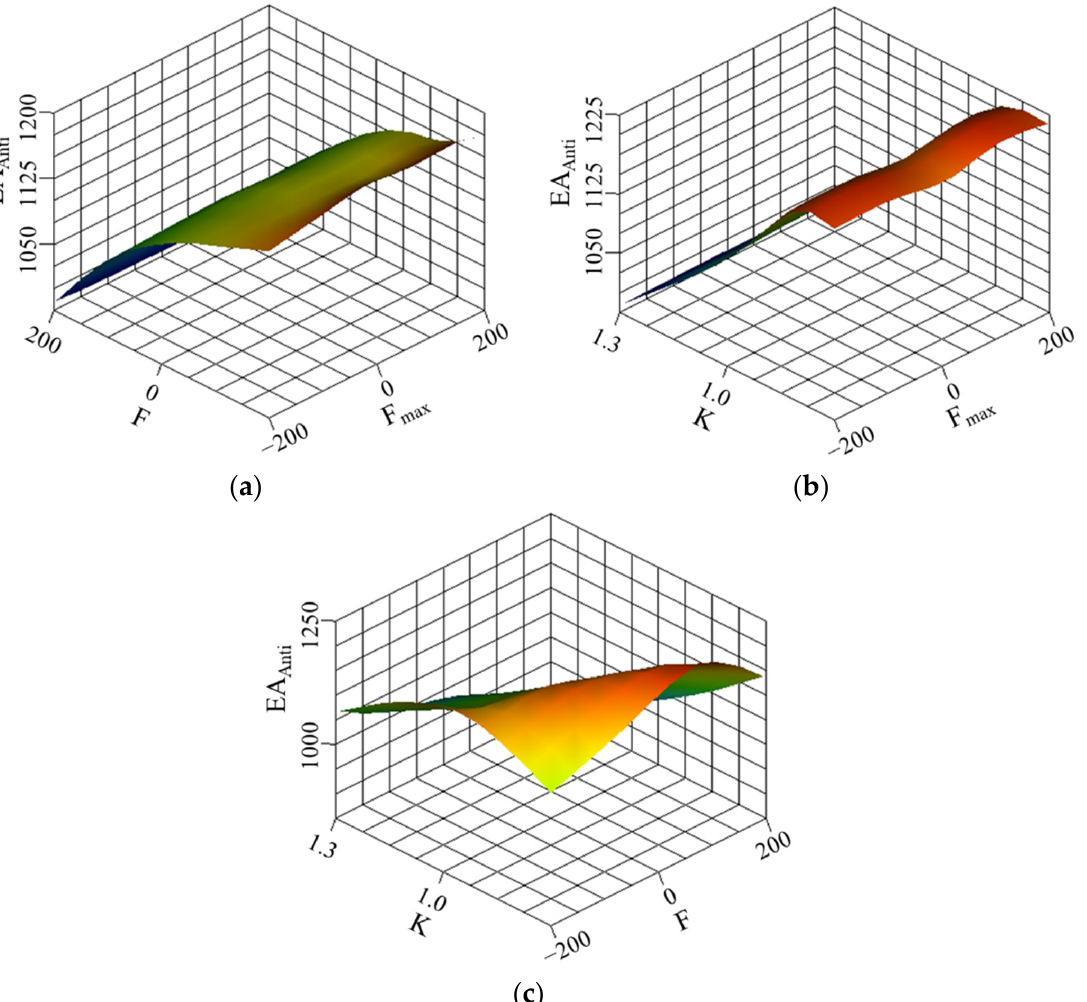
Figure 20. Influence of three variables on EA Anti : ( a ) F and F max ; ( b ) K and F max ; ( c) K and F. Figure 22 depicts a regression plot of 30 sets of test data to represent the correlation between the surrogate model constructed by radial basis functions and dynamic simulation. It can be seen from the figure that the points of the predicted value of the surrogate model and the calculated value of the dynamic simulation are distributed near the 45-degree line, indicating that the accuracy of the surrogate model is great and the results are reliable, which can be used for further